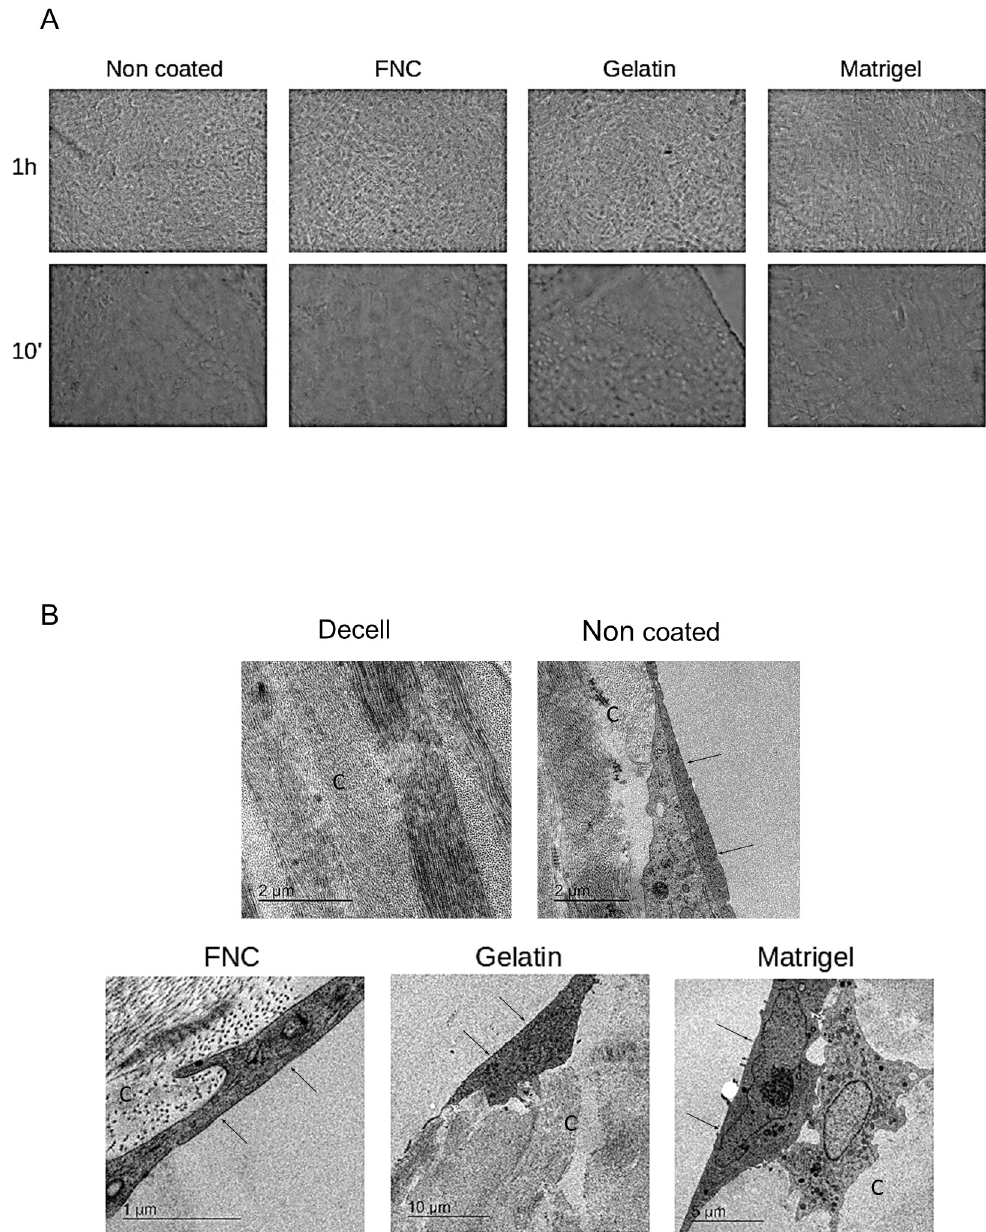
Fig 2. hCEC colonized laminas characterization. (A) Phase contrast images of corneal laminas with various coatings and repopulated with hCECs. Sheets were subjected to 10 minutes or 1 hour of centrifugation. (B) Electron microscopy images of various coated laminas after 1 hour of centrifugation. Note the perfectly aligned collagen bundle fibres in the decellularized lamina (Decell). Also, note the flat endothelial morphology and filopodia development between parallel collagen fibres in the FNC-coated sheet in comparison with double-layered cells in uncoated and Matrigel-coated sheets, and the poor adhesion in the gelatine-coated and uncoated sheets. C: Collagen fibres. Arrows: endothelial cells. showed good cell-to-cell and cell-to-substrate interactions with hemidesmosomes and filopo- dia formation, respectively. Adhesion was better when the laminas were centrifuged for 1 hour. Noncoated laminas showed poor adhesion to decellularized stroma and developed fewer cell interactions. Gelatin-coating laminas did not attain good adhesion of hCECs. Interestingly,